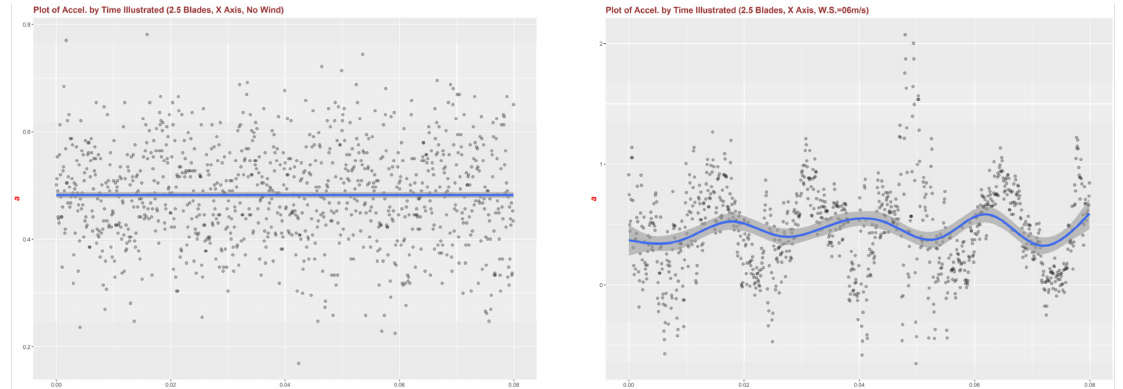
Figure A4. Magnitude and trend of acceleration for the full (normal) 3.0-blade turbine. ( a ) Based on datasets recorded along the X axis with different wind-speeds imposed. ( b ) Based on datasets recorded along the Y axis with different wind-speeds imposed. ( c ) Based on datasets recorded along the Z axis with different wind-speeds